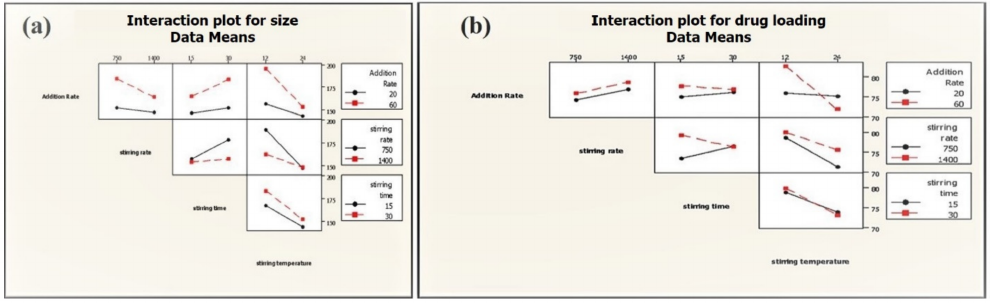
Figure 8. Interactions of PP on average particle size ( a ) and drug loading ( b ) of phytosome. Table 2. Design of Experiment (DoE) of material attributes (MA) for nanophytosome batches. H and L denote high and low, respectively.